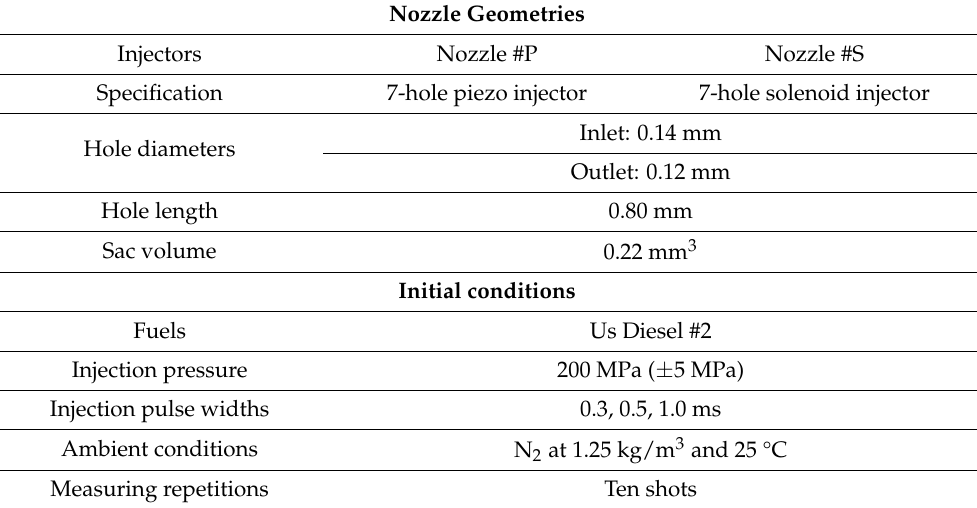
Table 2. Experimental conditions.